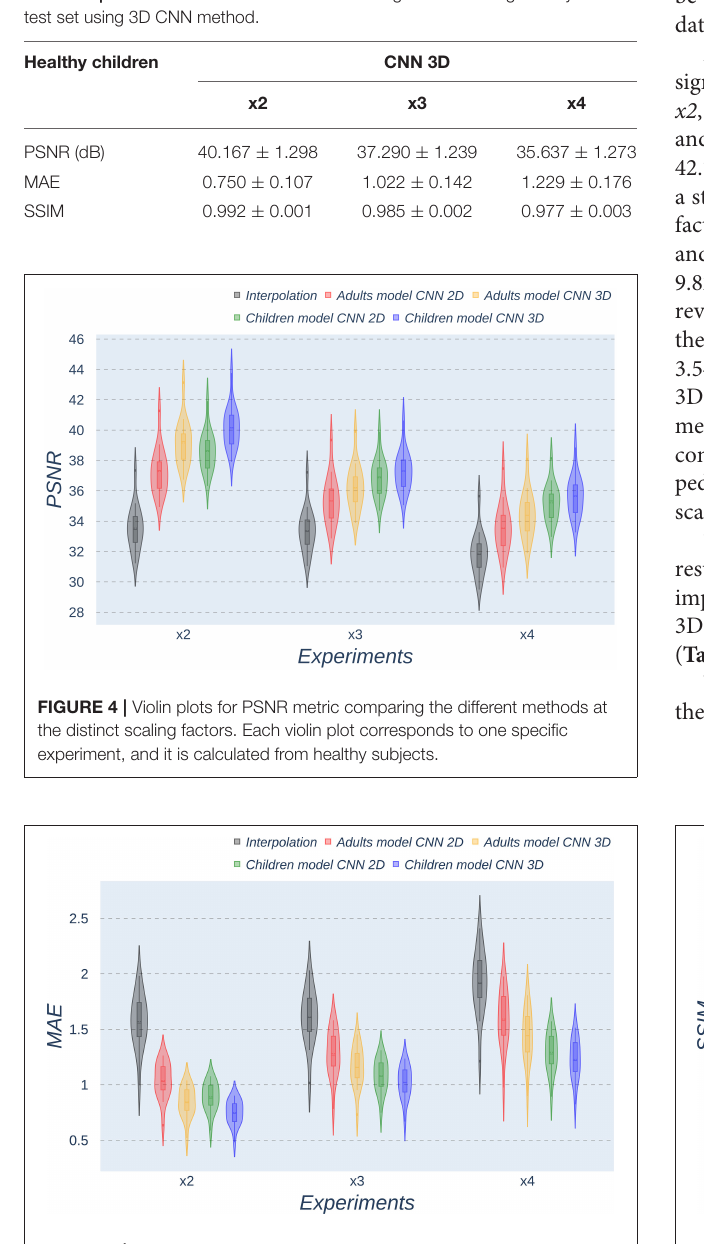
FIGURE 5 | Violin plots for MAE metric comparing the different methods at the distinct scaling factors. Each violin plot corresponds to one specific experiment, and it is calculated from healthy subjects. experiment, and it is calculated from healthy